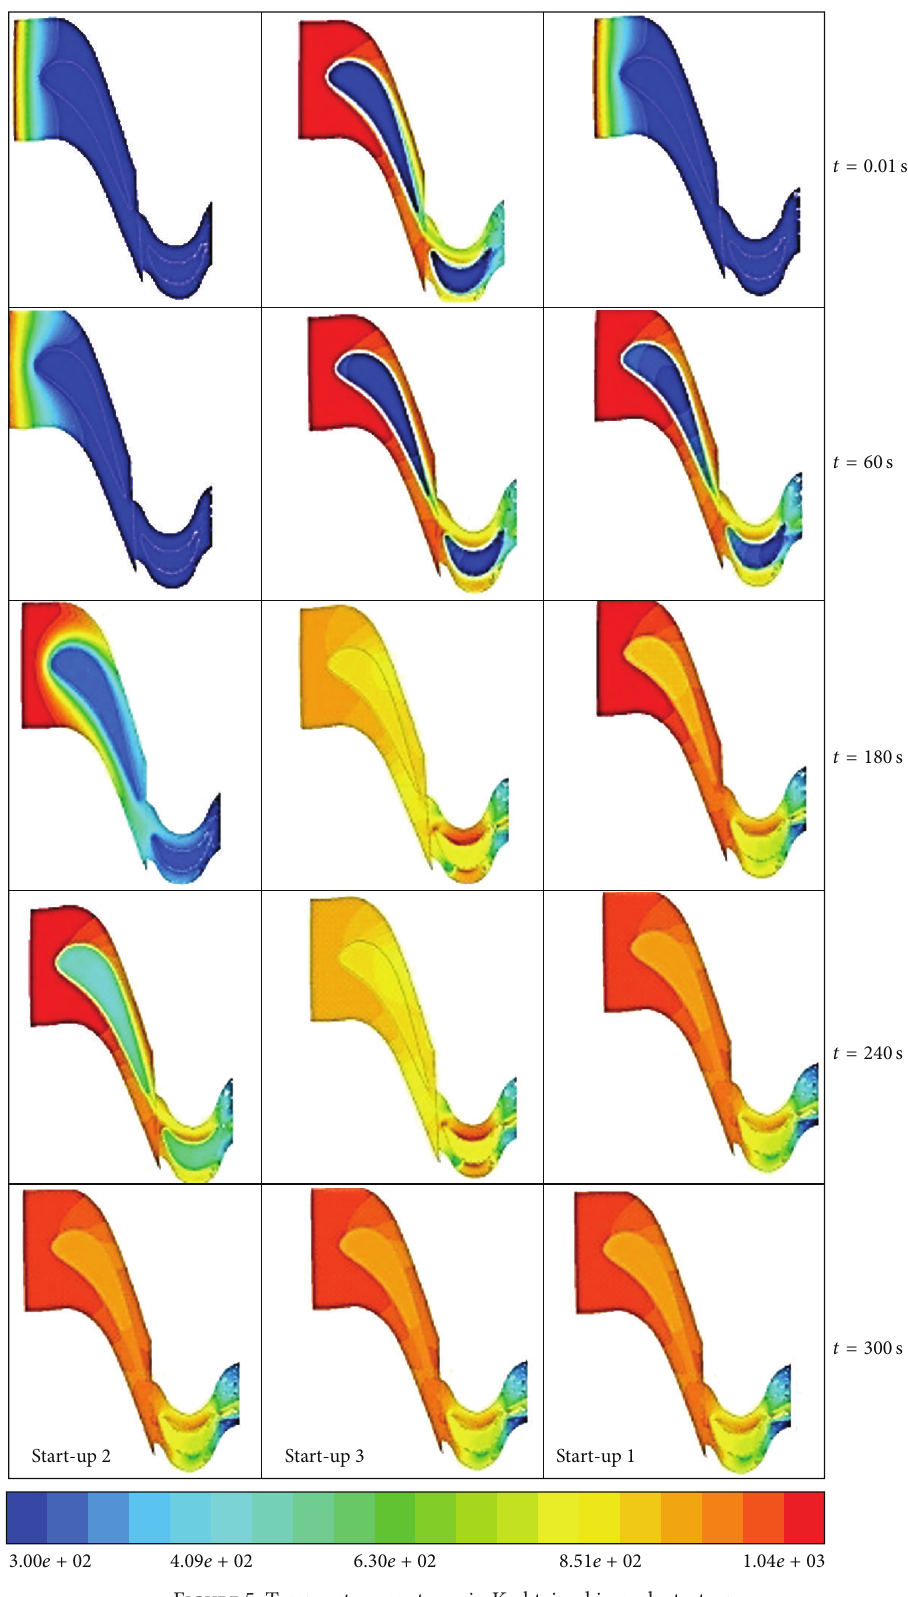
Figure 5: Temperature contours in K obtained in each